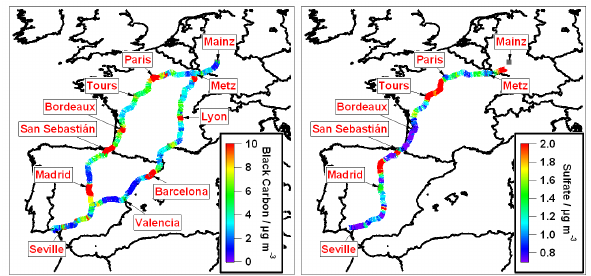
Fig. 8. Black carbon (left) and particulate sulfate (right) concen- trations along the 2500km trip from Mainz, Germany to southern Spain as part of the DOMINO field campaign in November 2008. While black carbon concentrations reflect the urban centers along the route quite well, sulfate has a more regional distribution. These differences reflect the sources and generation mechanisms of the two